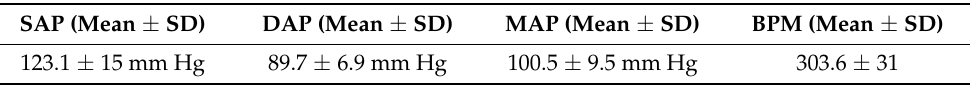
Table 1. Cardiovascular parameters. Systolic (ASP), diastolic (DAP), and mean (MAP) vascular pressure in mmHg and cardiac rhythm in beat per minute (BPM) were measured on six mice.